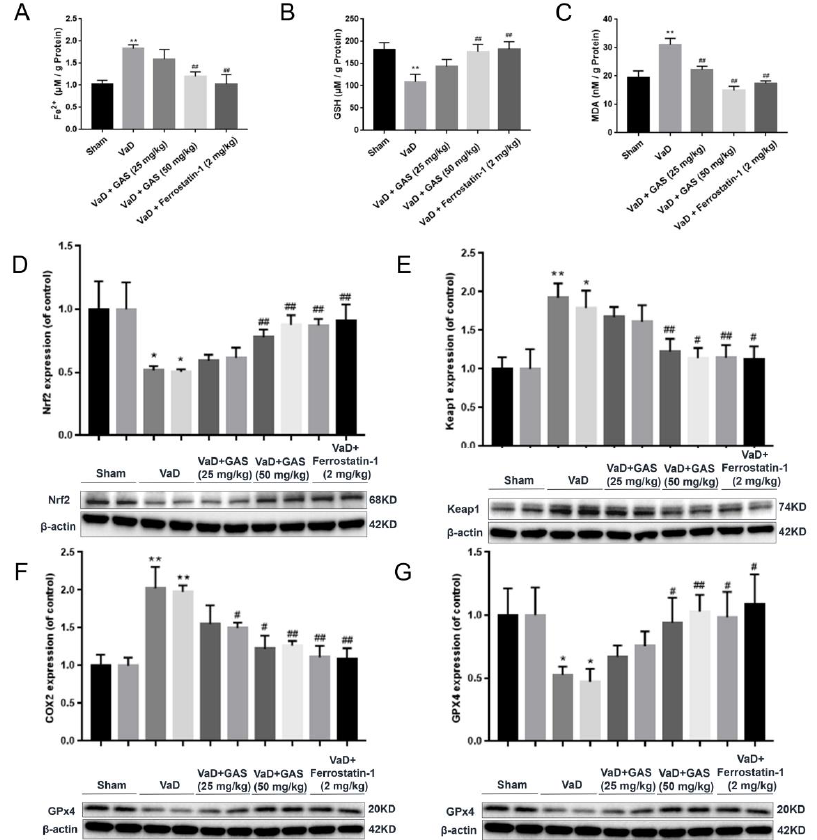
Figure 2. Effects of GAS on ferroptosis indexes in the hippocampus of VD rats. ( A – C ), detection of biochemical indicators of ferroptosis, ( D – G ), Western blot analyses of ferroptosis-related protein expression. Results are shown as mean ± SD ( n = 6).* p < 0.05, ** p < 0.01 specifies the differences between sham rat and VaD rat. # p < 0.05, ## p < 0.01 compares between VaD rat and GAS-treated rat or ferrostatin1-treated rat.